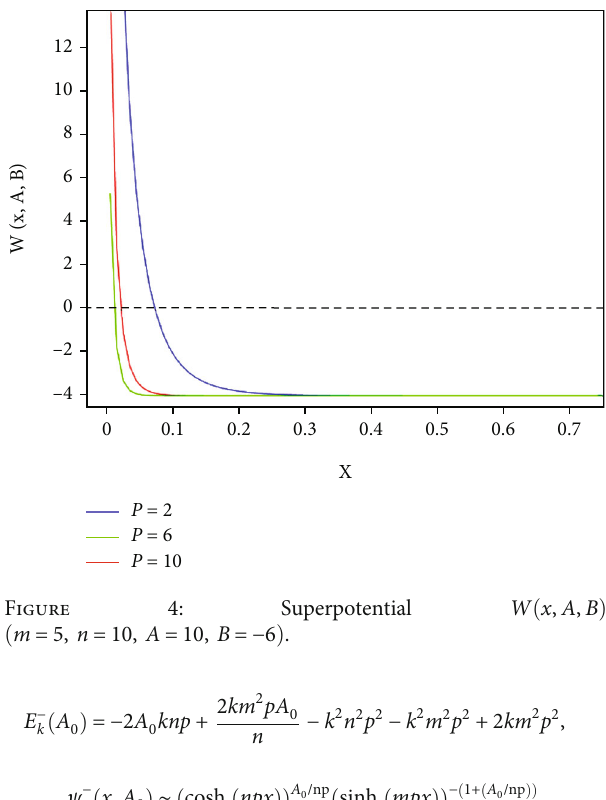
Figure 4: Superpotential W ð x , A , B Þ ð m = 5, n = 10, A = 10, B = − 6 Þ